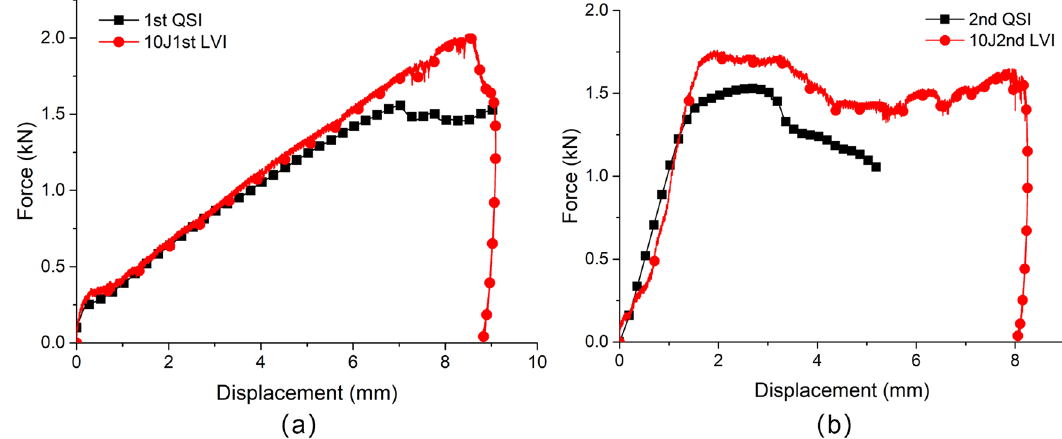
Figure 8: Comparison of force – displacement curves of specimen at same depth: ( a ) 7.2 mm and ( b ) 12.2